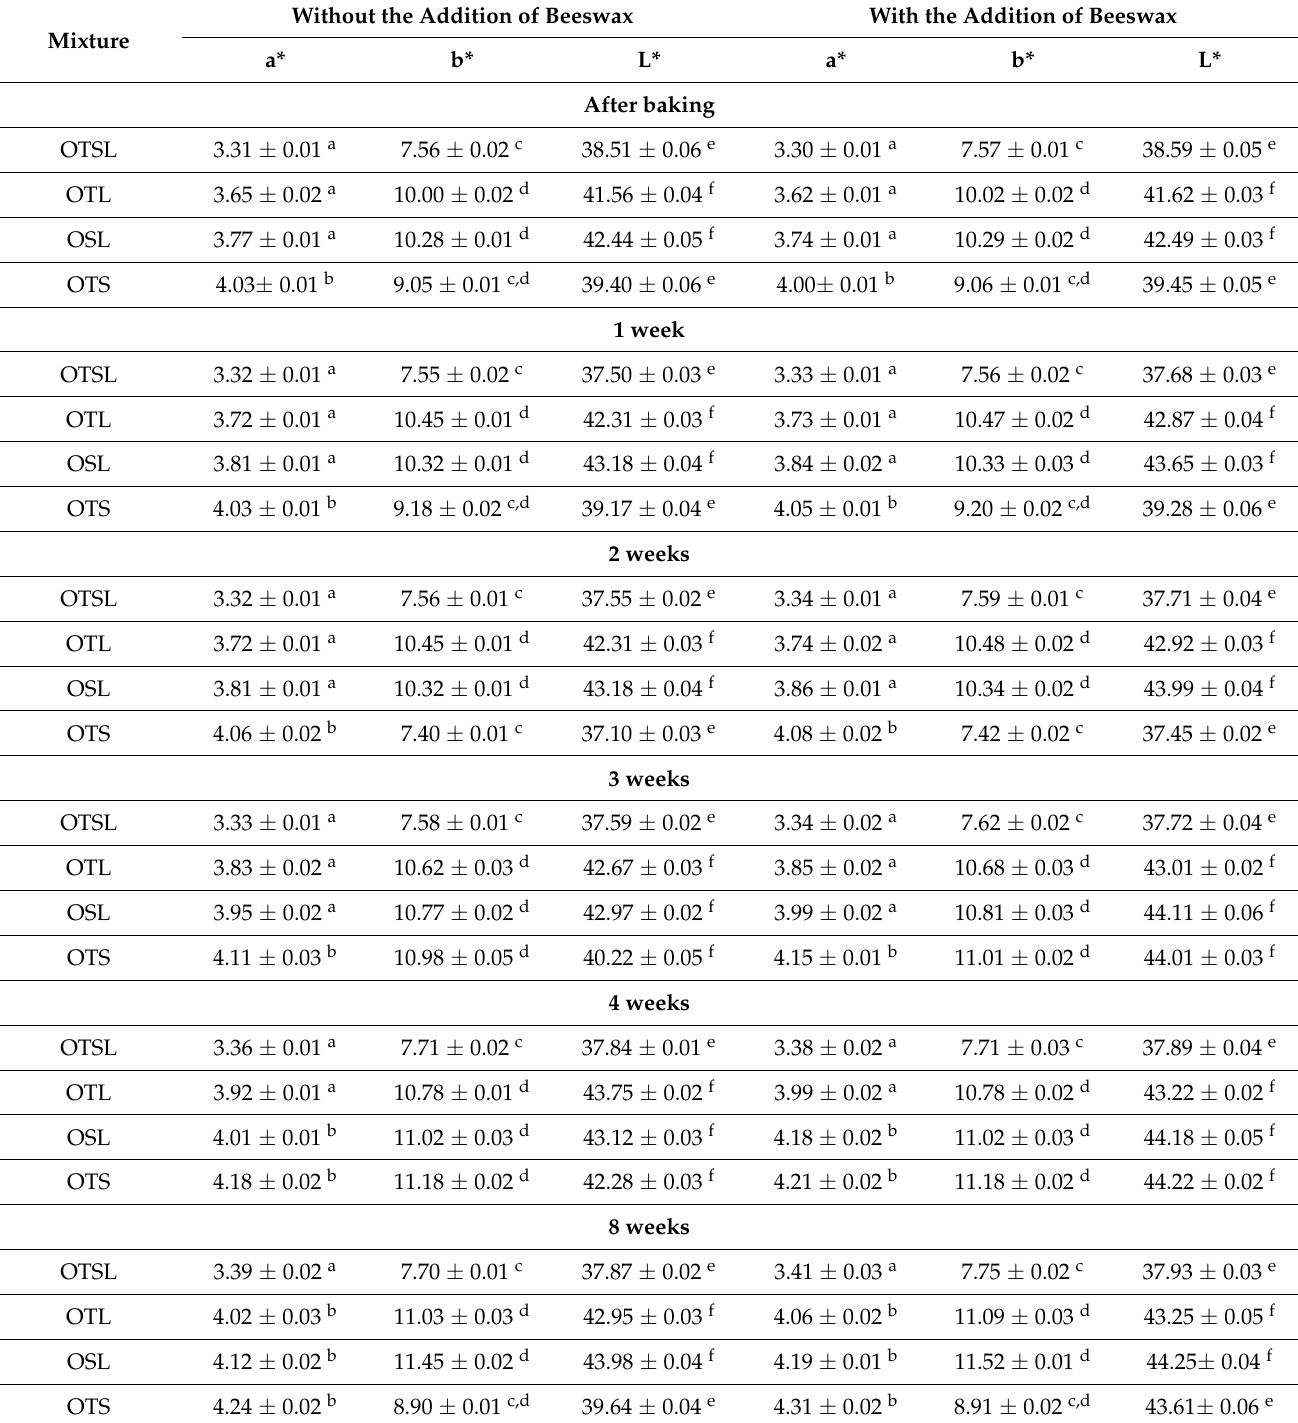
Table 3. Parameters for measuring the color of disposable